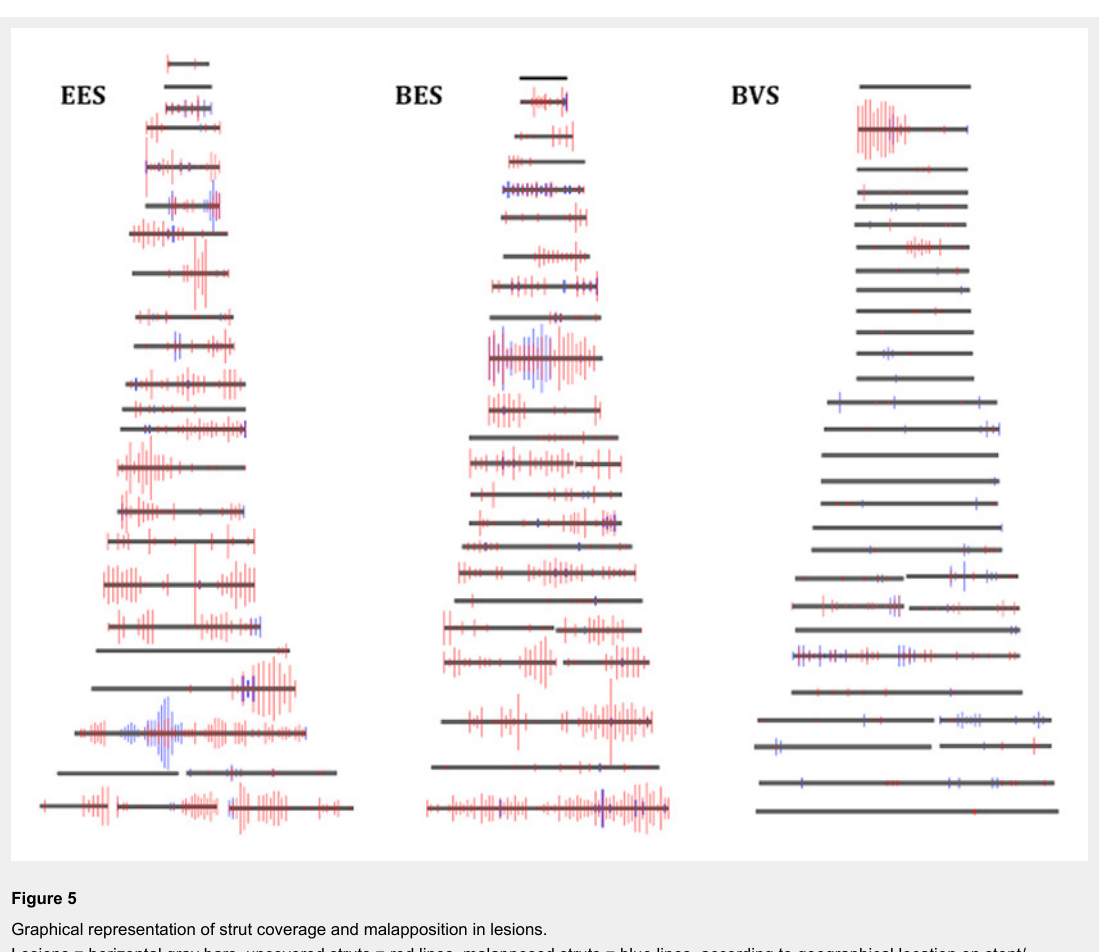
Figure 5 Graphical representation of strut coverage and malapposition in lesions. Lesions = horizontal gray bars, uncovered struts = red lines, malapposed struts = blue lines, according to geographical location on stent/ scaffold. BES = biolimus-eluting stent; BVS = bioresorbable vascular scaffold; EES = everolimus-eluting